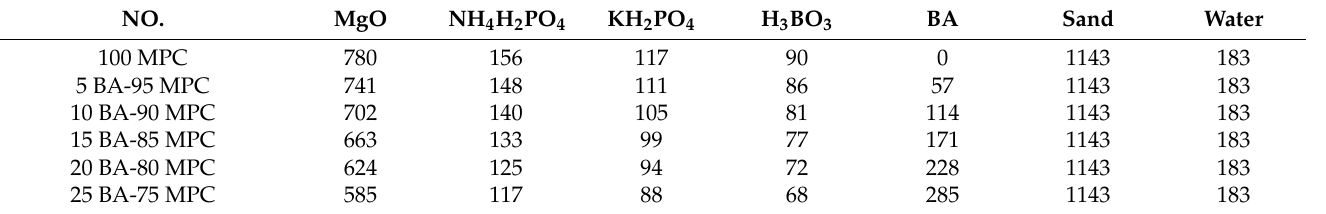
Table 2. Mix design of BA ‐ MPC mortars composites (kg/m 3 ).